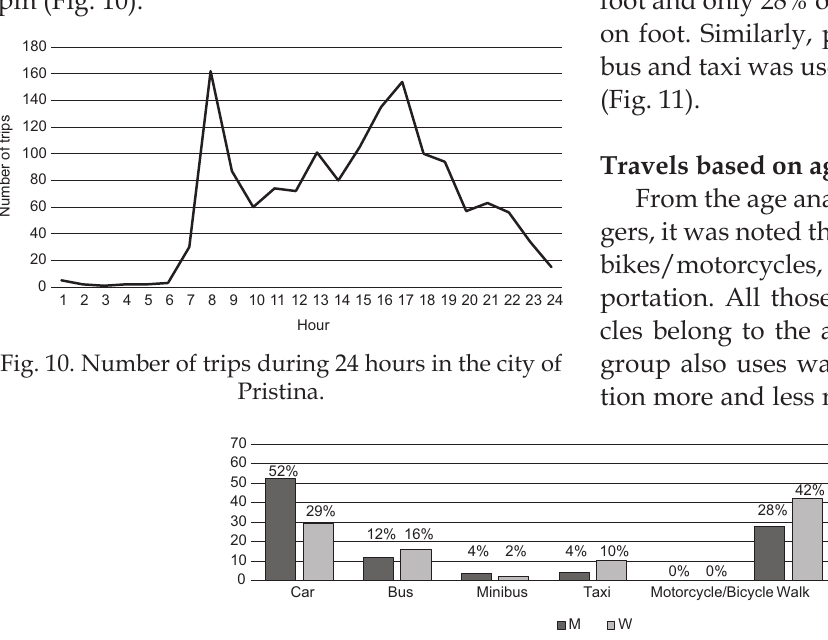
Fig. 11. Travels based on gender and type of